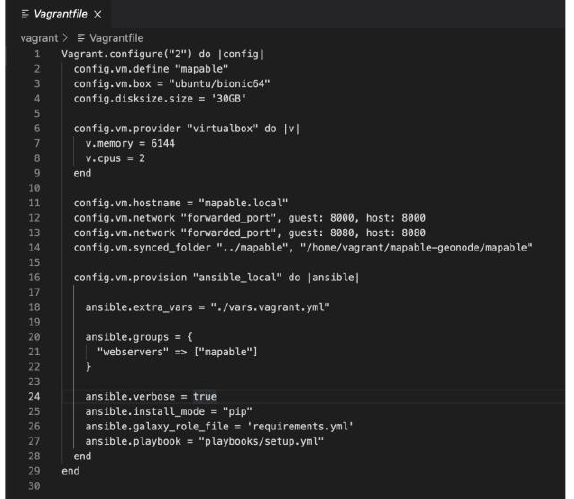
Figure 5. Vagrant configuration file for Web Portal development environment.